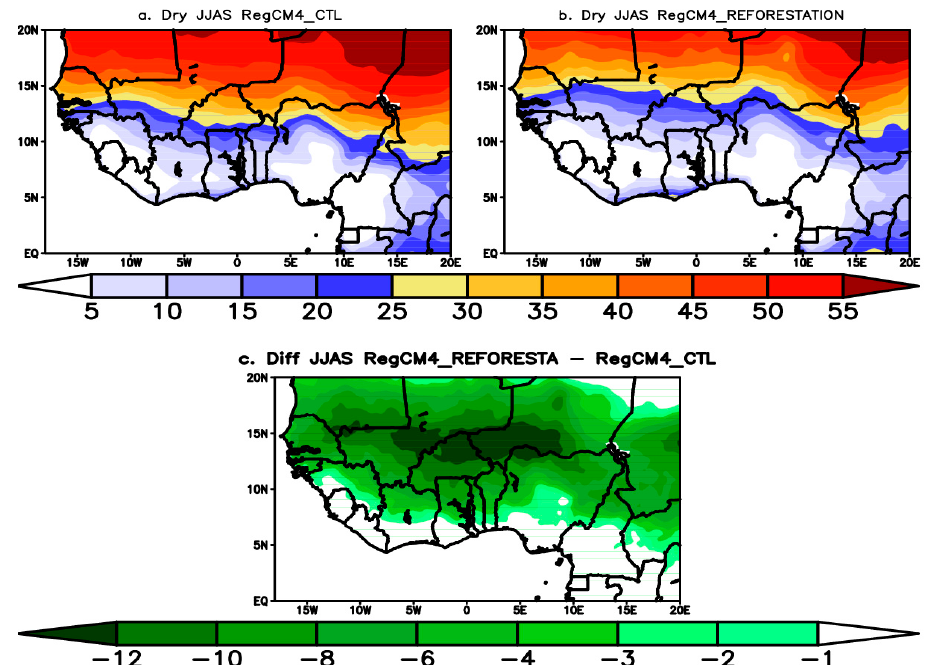
Figure 4. Number (expressed in days) of extreme dry days during the JJAS period averaged from 1990 to 2009 over West Africa for: ( a ) RegCM4_CTL; ( b ) RegCM4_REFORESTATION and ( c ) RegCM4_REFORESTATION—RegCM4_CTL.